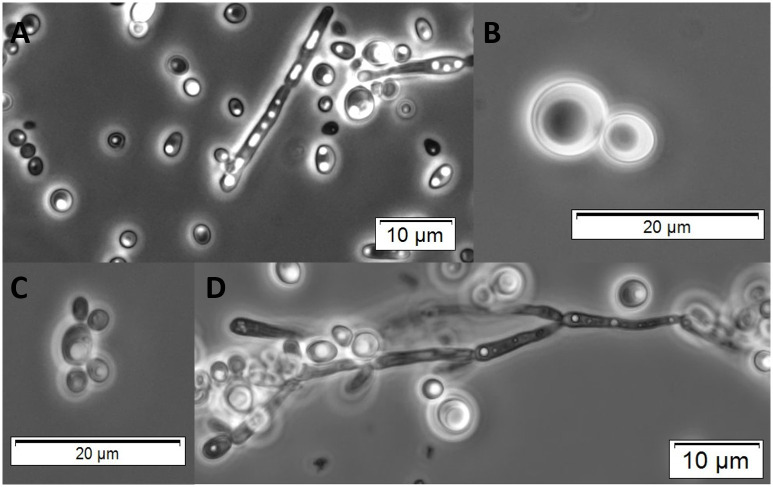
Micromorphology of Candida metrosideri and Candida ohialehuae.Multipolar budding and pseudohyphae of Candida ohialehuae JK58.2T (A, C and D, respectively), and budding cells of Candida metrosideri JK22T (B).